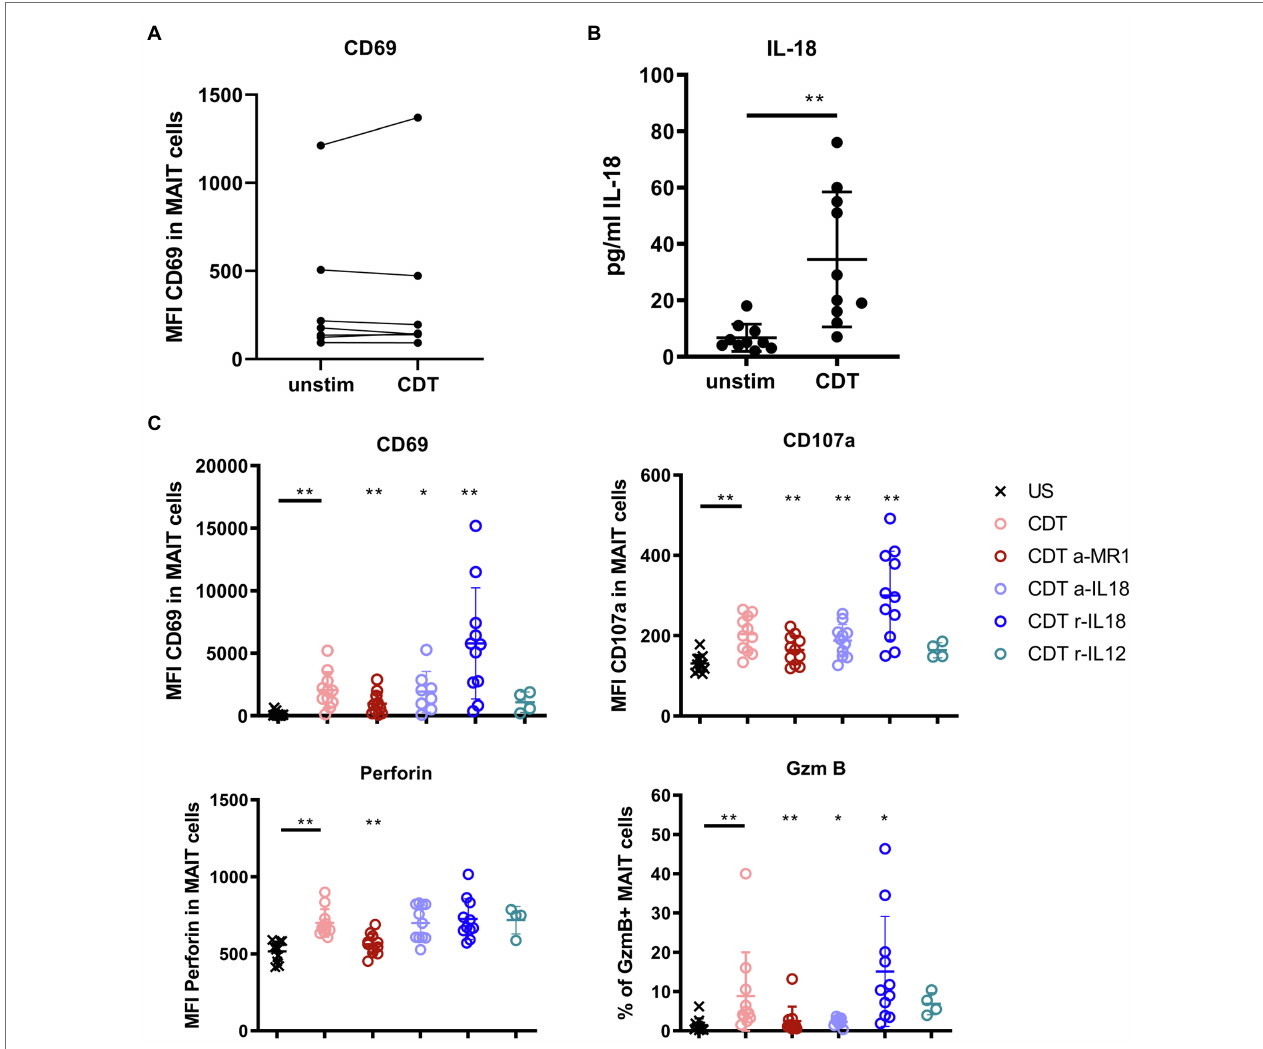
FIGURE 4 | Contribution of IL-18, IL-12, and MR1 to CDT-induced MAIT cell activation and cytotoxicity. C. difficile CDT (100 ng/ml) was directly applied to isolated CD161 ++ V α 7.2 + CD3 + MAIT cells from seven healthy donors for 20 h and MAIT cell activation (CD69) was examined by flow cytometric analyses (A) . C. difficile CDT (100 ng/ml) was applied to total PBMC fractions from 4 to 11 human donors for 20 h followed by quantification of IL-18 in the PBMC supernatant or flow cytometric analysis of CD69, CD107a, intracellular granzyme B (GzmB), perforin, and IFN γ in MAIT cells (B,C) . If indicated, PBMCs were treated with anti-IL-18 (a-IL18), recombinant IL-18 (r-IL18), recombinant IL-12 (r-IL12) or anti-MR1 (a-MR1) prior CDT stimulation. Horizontal lines indicate mean ± SD. Asterisks indicate